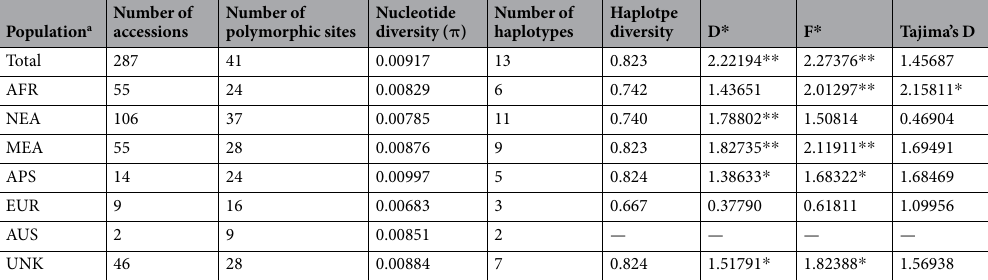
Table 2. Barley HvP5CS1 nucleotide diversity ( π ), haplotype diversity and selection (D * and F * , and Tajima’s D) statistics for each geographic region. a AFR: Africa, APS: Arabian Peninsula, AUS: Australia, EUR: Europe, MEA: Middle East Asia, NEA: North East Asia, UNK: country of origin not known. * P ≤ 0.05; ** P ≤